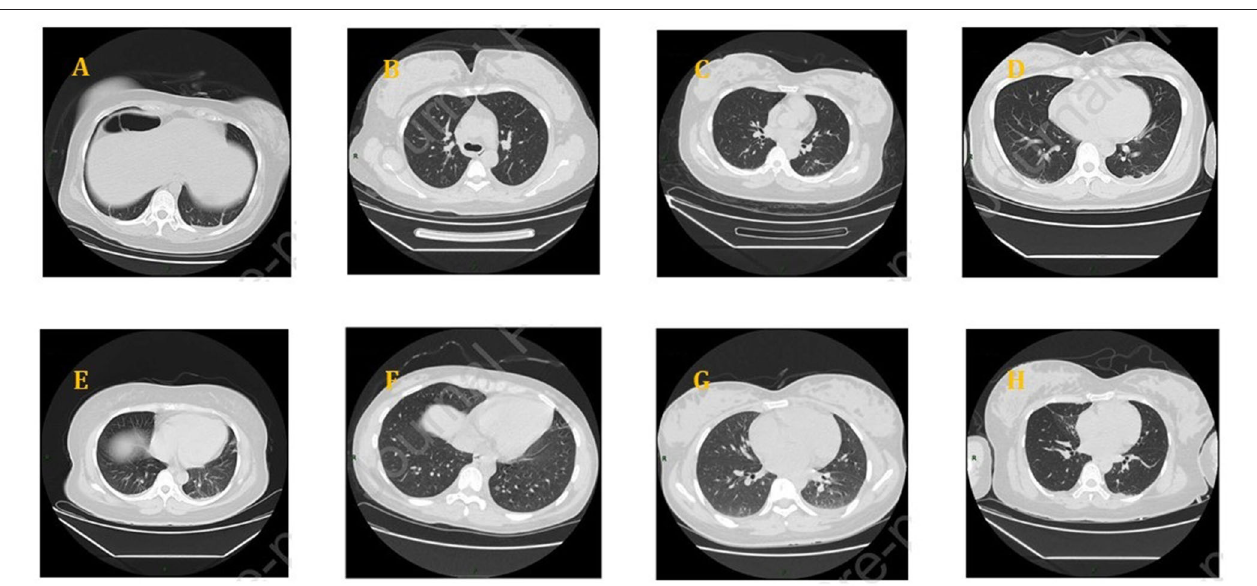
FIGURE 1 | Chest CT scans of pregnant women with COVID-19: (A) bilateral lower lung cord, (B) a ground-glass nodule on the right upper lobe, (C) denser shadows scattered on the right lower lobe, (D) a little patchy shadow on the dorsal side of bilateral lower lungs and a little pleural effusion, (E) patchy shadows on bilateral lungs and a small amount of pleural effusion on both sides, (F) ground-glass density nodules on the left, (G) patches near the pleura, bilateral pleural effusion, and (H) ground glass and patch shadows scattered on the bilateral